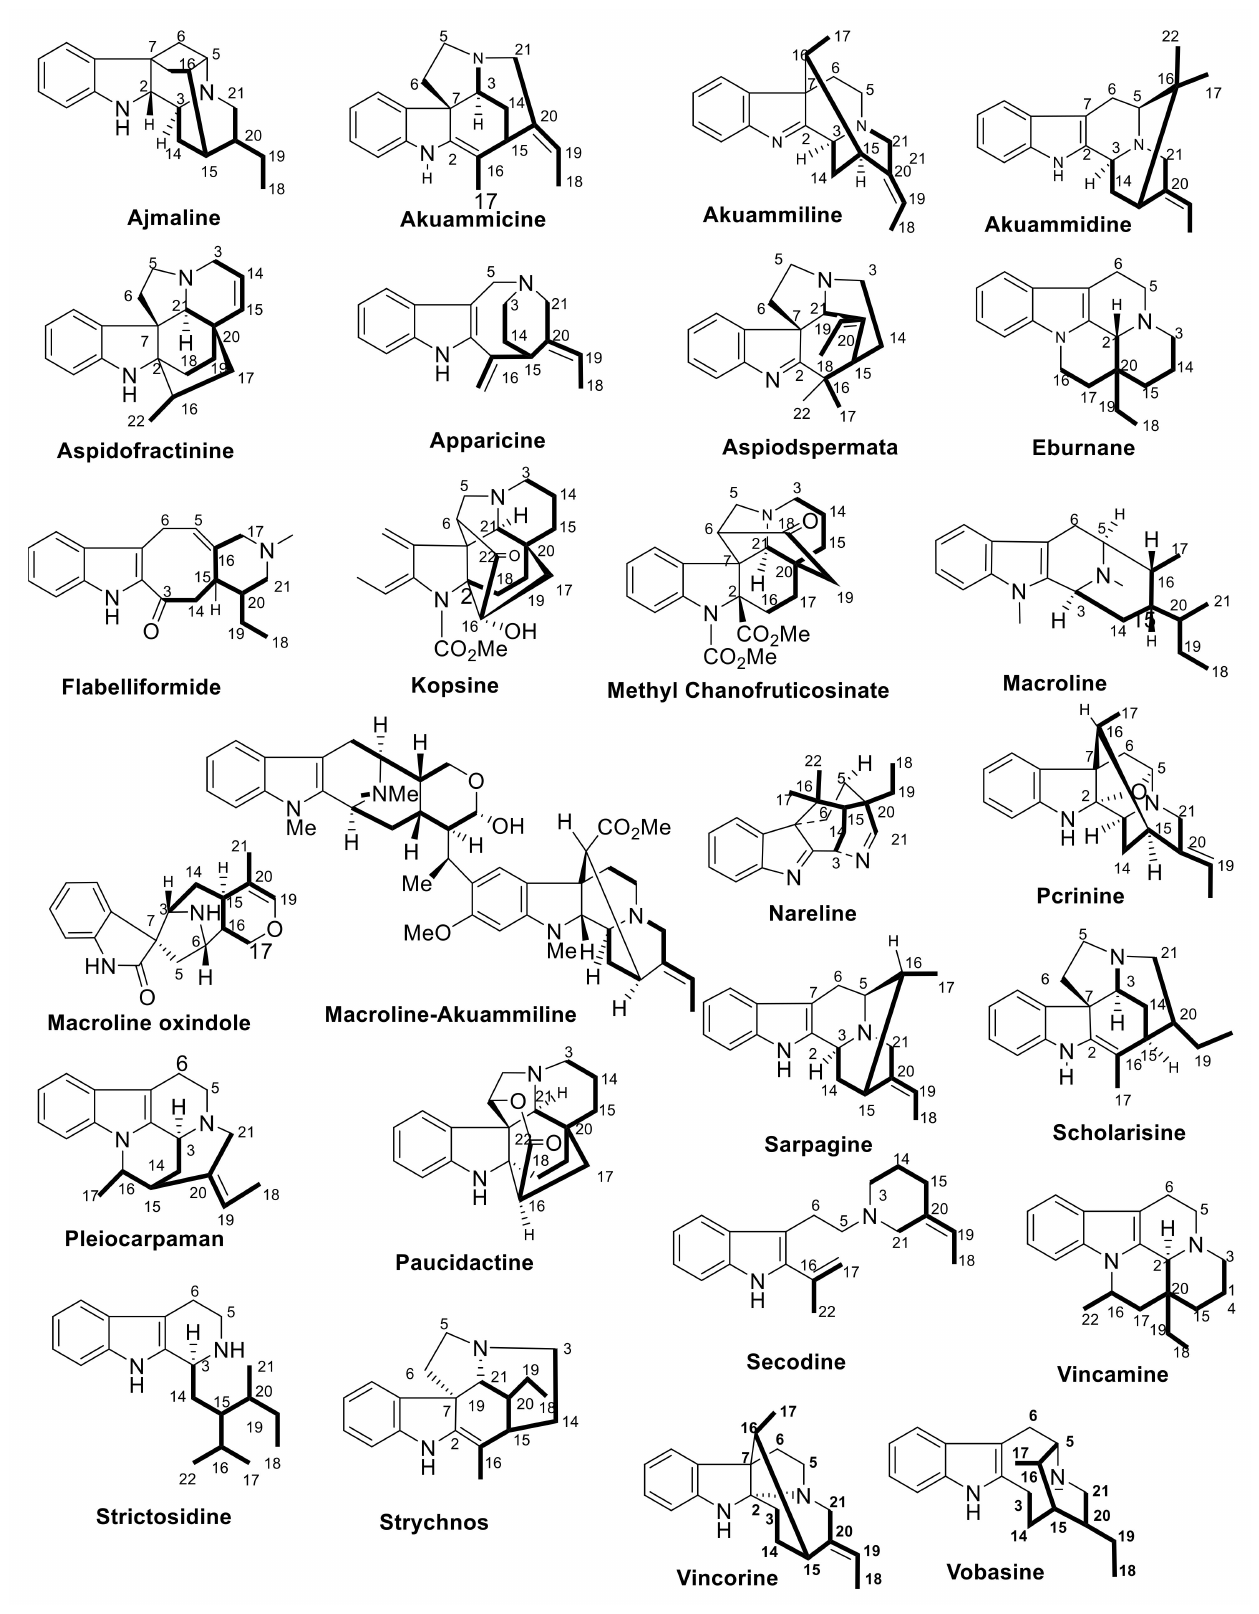
Figure 4. Common monoterpenoid indole alkaloidal skeletons of the six